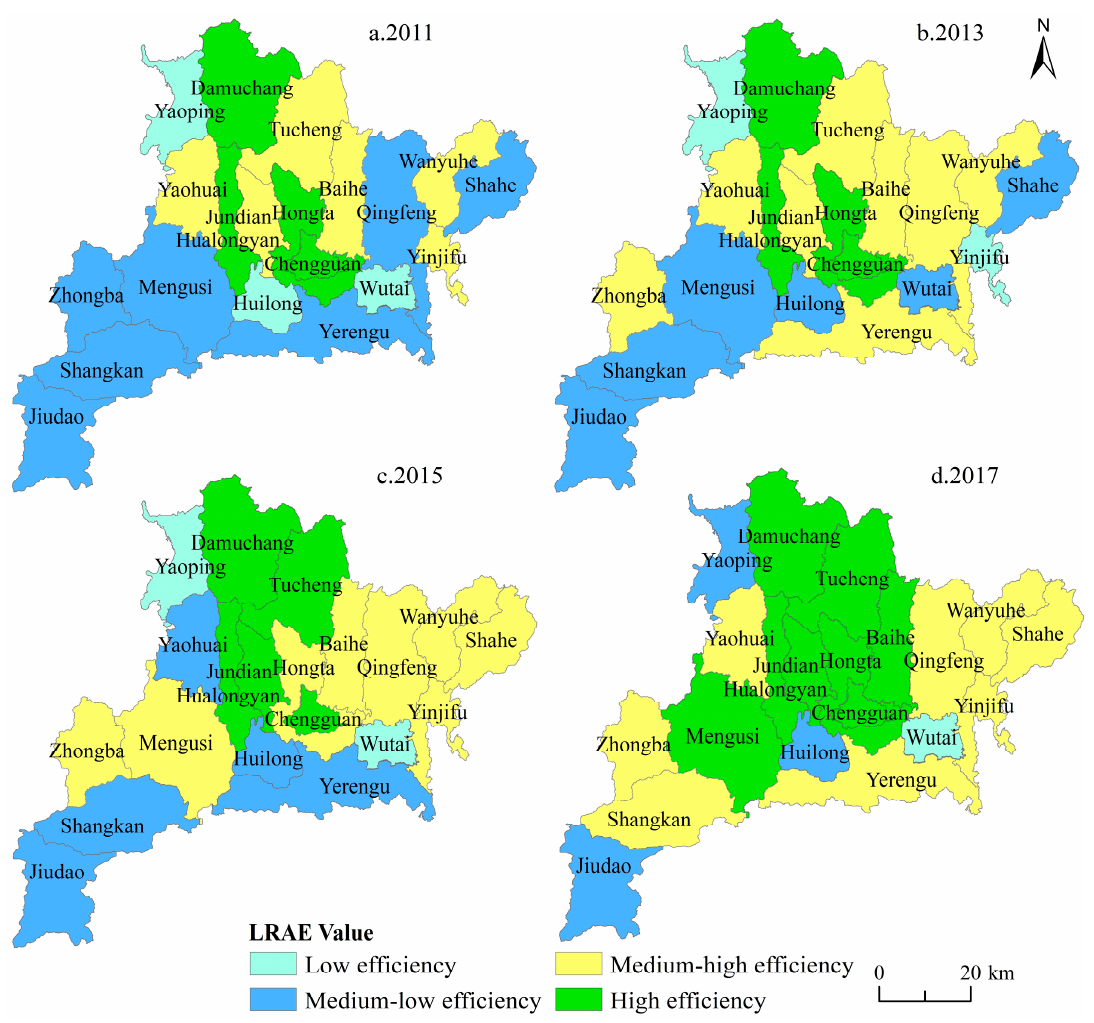
Figure 3. Spatiotemporal distribution of rural LRAE at township scale in Fang County from 2011 to 2017.